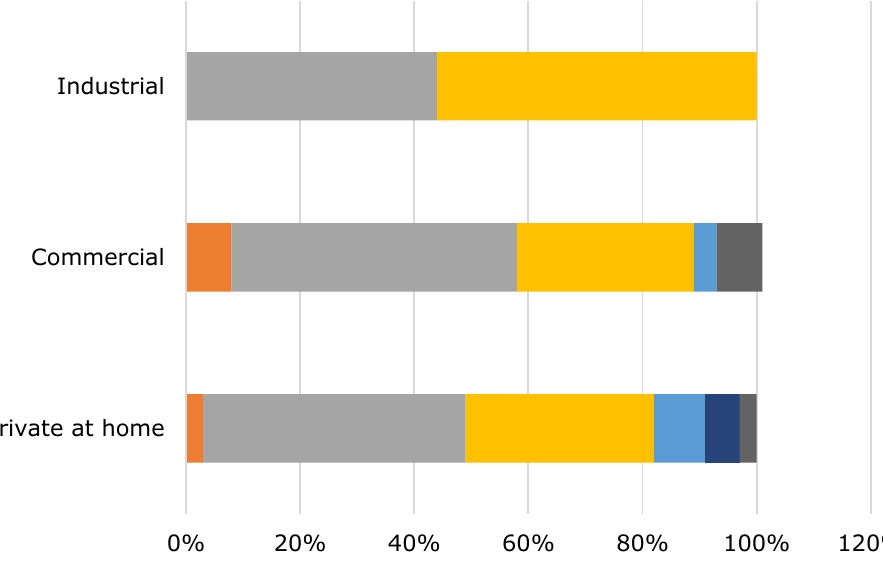
Figure 2. Extraction temperature of cold brew coffee.